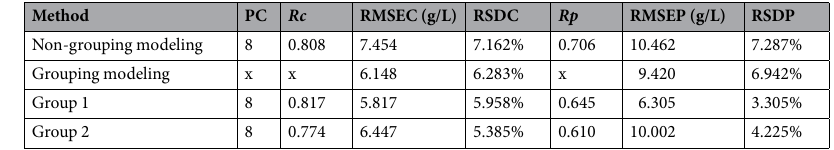
Table 2. Results comparison between non-grouping modeling and grouping modeling. Note: PC: number of principal components; Rc : correlation coefficient of calibration set, Rp: c orrelation coefficient of prediction set.